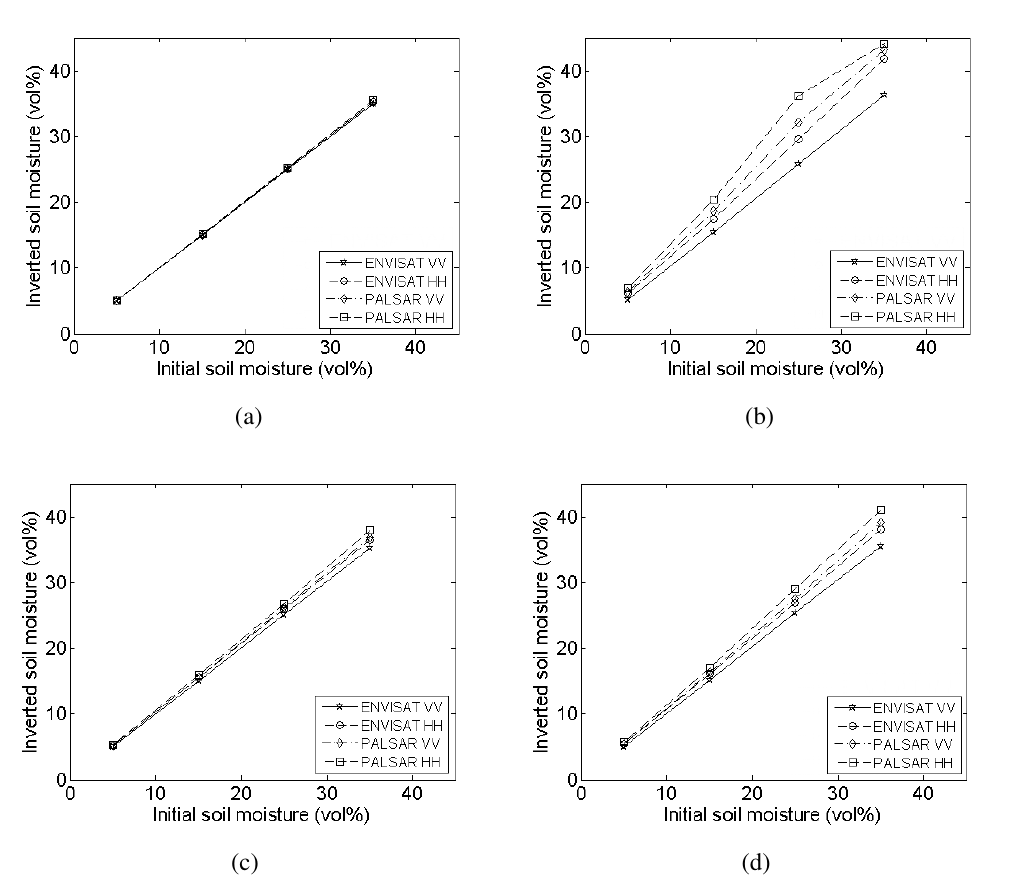
Figure 14. Mean inverted soil moisture contents for different radar configurations, using roughness parameters obtained after (a) linear detrending over the 4-m profile, (b) piecewise 1-m detrending, (c) second-order polynomial detrending and (d) third-order polynomial de- trending of 10 synthetical roughness profiles of ( s , l ) = (1 cm,5 cm) with added linear